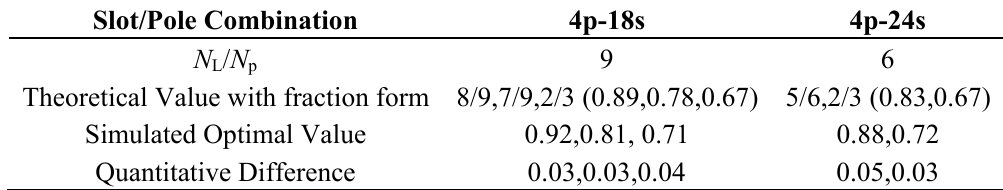
Figure 5. Influence of the magnetic-pole embrace on the cogging torque. Table 5. The Optimal Magnetic-Pole Embrace.